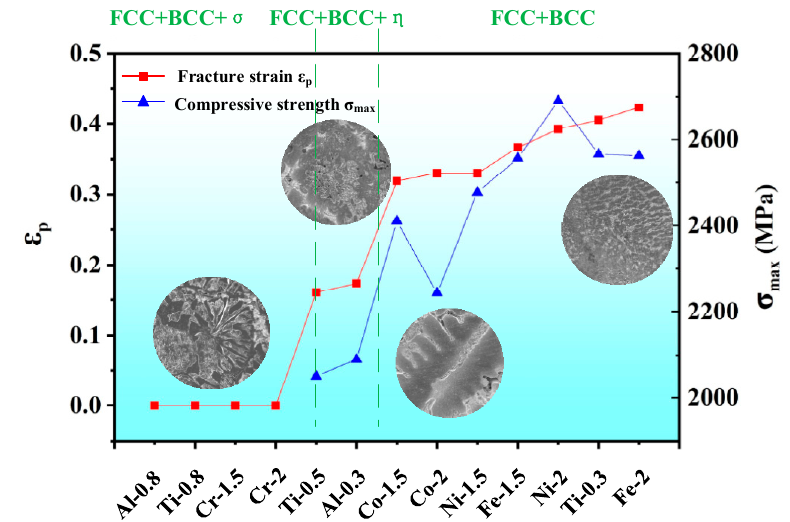
Figure 9. Performance curve of AlCoCrFeNiTi HEAs.